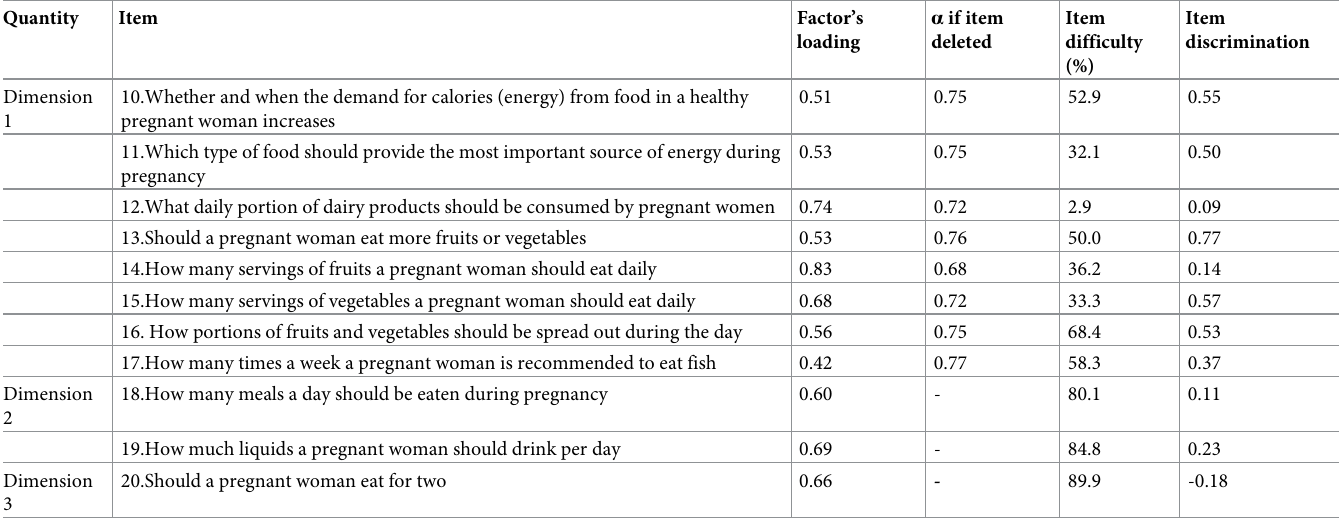
Table 6. Quantity of food intake: Factor analysis and reliability analysis